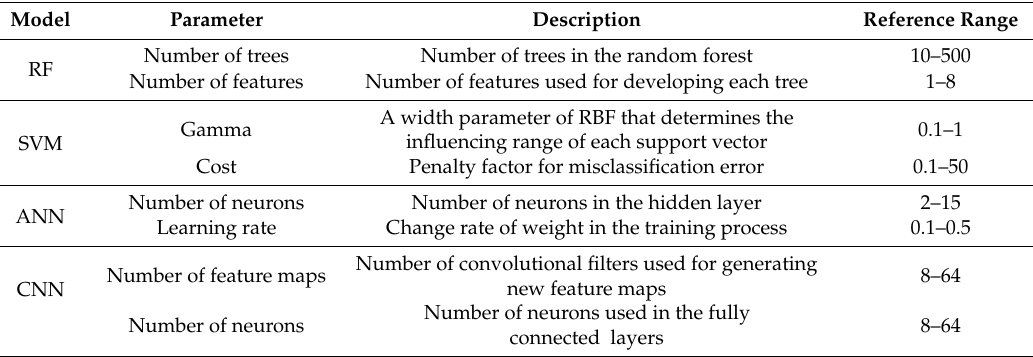
Table 1. Parameters used for training machine learning